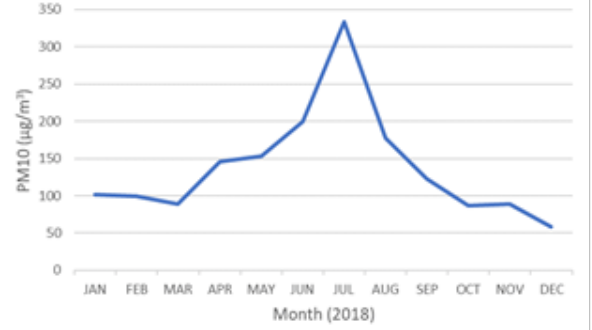
Figure 4 . Monthly average PM10 concentrations.